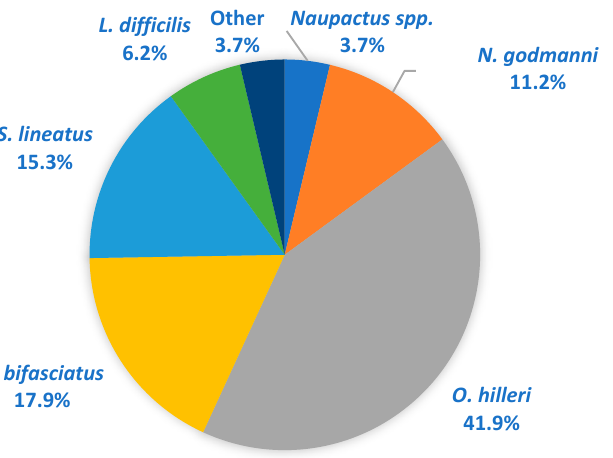
Figure 7. Weevil species composition. The weevils found on peach roots caught from May 2019 to May 2020 (2480 total adult weevils), with common clades identified.